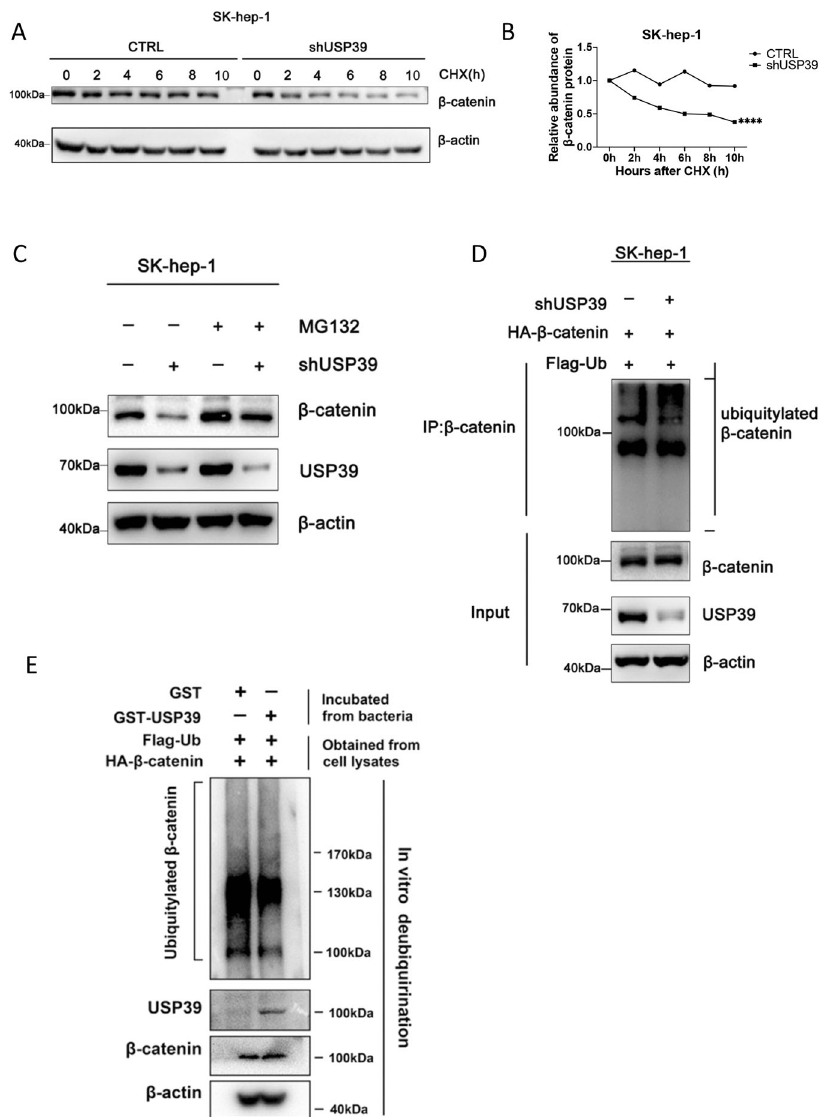
Fig. 3 Loss of USP39 led to an increase in the ubiquitination of β -catenin. A, B . β -catenin protein level in SK-hep-1 cells under the downregulation of USP39 at the indicated times after CHX (0.2 mg/ml) addition. C The protein level of β -catenin in USP39 down-regulated SK- hep-1 cells treated with MG132 (20 μ M), total protein was extracted and detected by Western blotting. D β -catenin ubiquitination in USP39 knockdown SK-hep-1 cells co-transfected with expression plasmids encoding HA- β -catenin and Flag-Ub. The transfected cells were treated with MG132 (20 μ M for 4 h) prior to harvest. E β -catenin deubiquitination by USP39 in vitro using puri fi ed proteins. Whole-cell lysates (containing Flag-Ub and HA- β -catenin proteins) were incubated with puri fi ed GST-USP39 or GST-plasmid in vitro and blotted with USP39 or β -catenin antibodies. All the data are representative of at least three independent experiments and presented as the means ± SD. (**** p < 0.0001 v.s. control by Student ’ s t